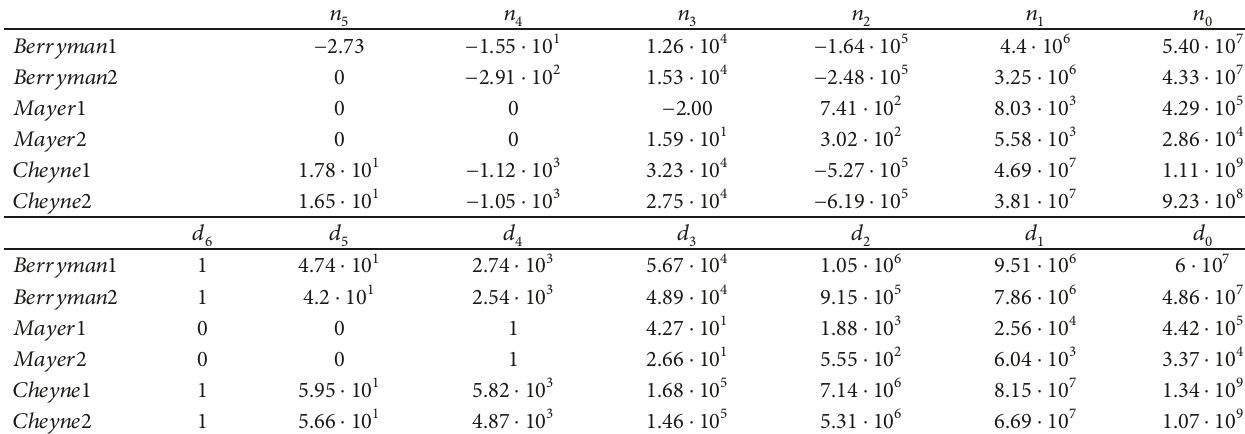
Table 3: Coefficients of lateral control transfer functions identified in ARISTOTEL.